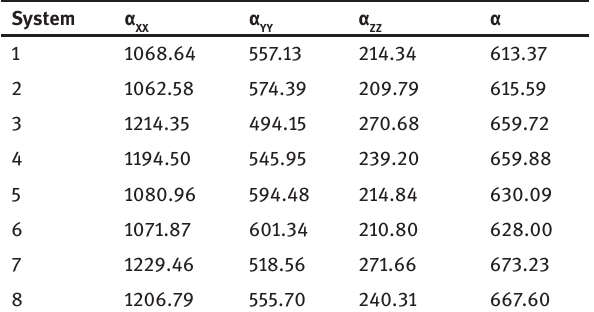
Table 2: Dipole polarizabilities and major contributing tensors